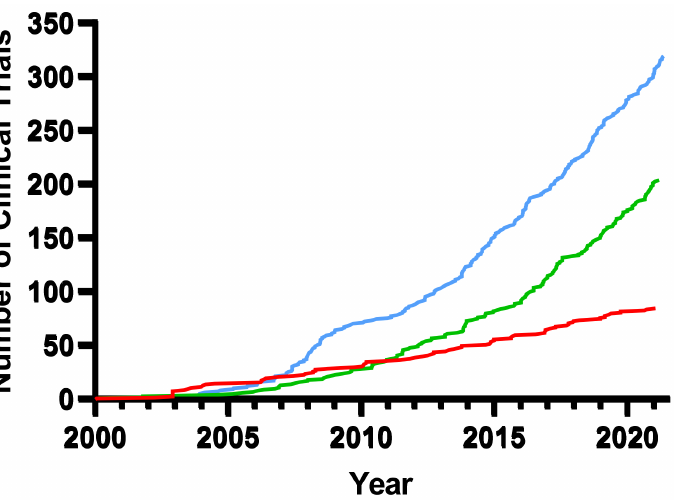
Figure 8. Running total of the number of clinical trials published since 1 March 2000 that inves- tigated NP, OV, or OB as cancer treatments in phase I–IV clinical trials. Between 1 March 2000 and 1 September 2021, 321 total clinical trials related to NP (blue) treating cancers were published; 203 total clinical trials related to OV (green) treating cancers were published; and 85 total clinical trials for OB (red) treating cancers were